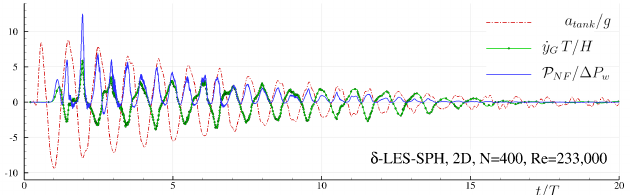
Figure 12. Test with water: time histories of the tank acceleration a tank , the fluid center of mass ˙ y G , and the power of the non-inertial forces P NF .